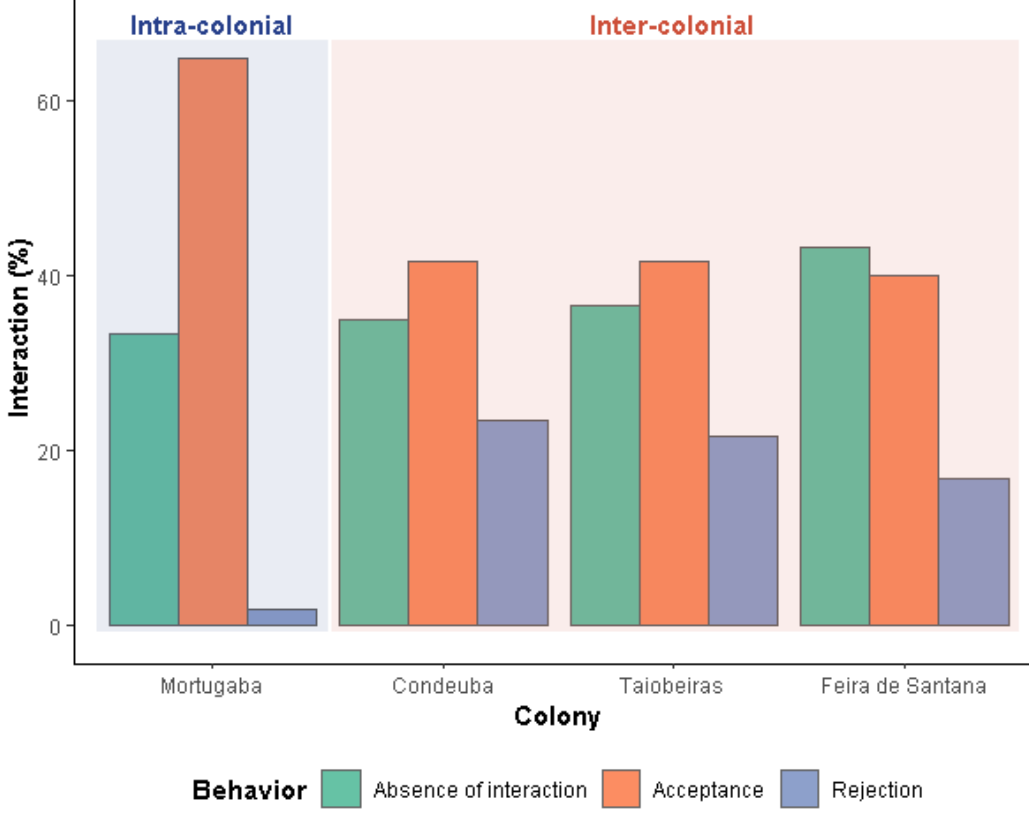
Fig 1. Acceptance, rejection and absence of interaction in intra-colonial confrontations with three colonies from the same location (Mortugaba) and inter-colonial confrontations involving 3 colonies from different locations (Condeúba, Feira de Santana and